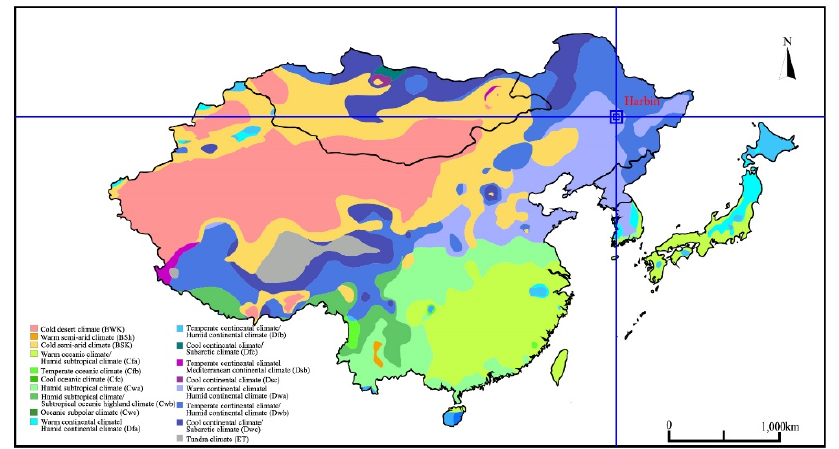
Figure 1. Location of Harbin in the Köppen–Geiger climate map of East Asia. Enhanced by the au- thors, derived from the Köppen–Geiger climate map in Wikipedia. The content of this website is licensed under CC BY-SA 3.0 (https://creativecommons.org/licenses/by-sa/3.0/, accessed on 28 Feb- ruary 2022).